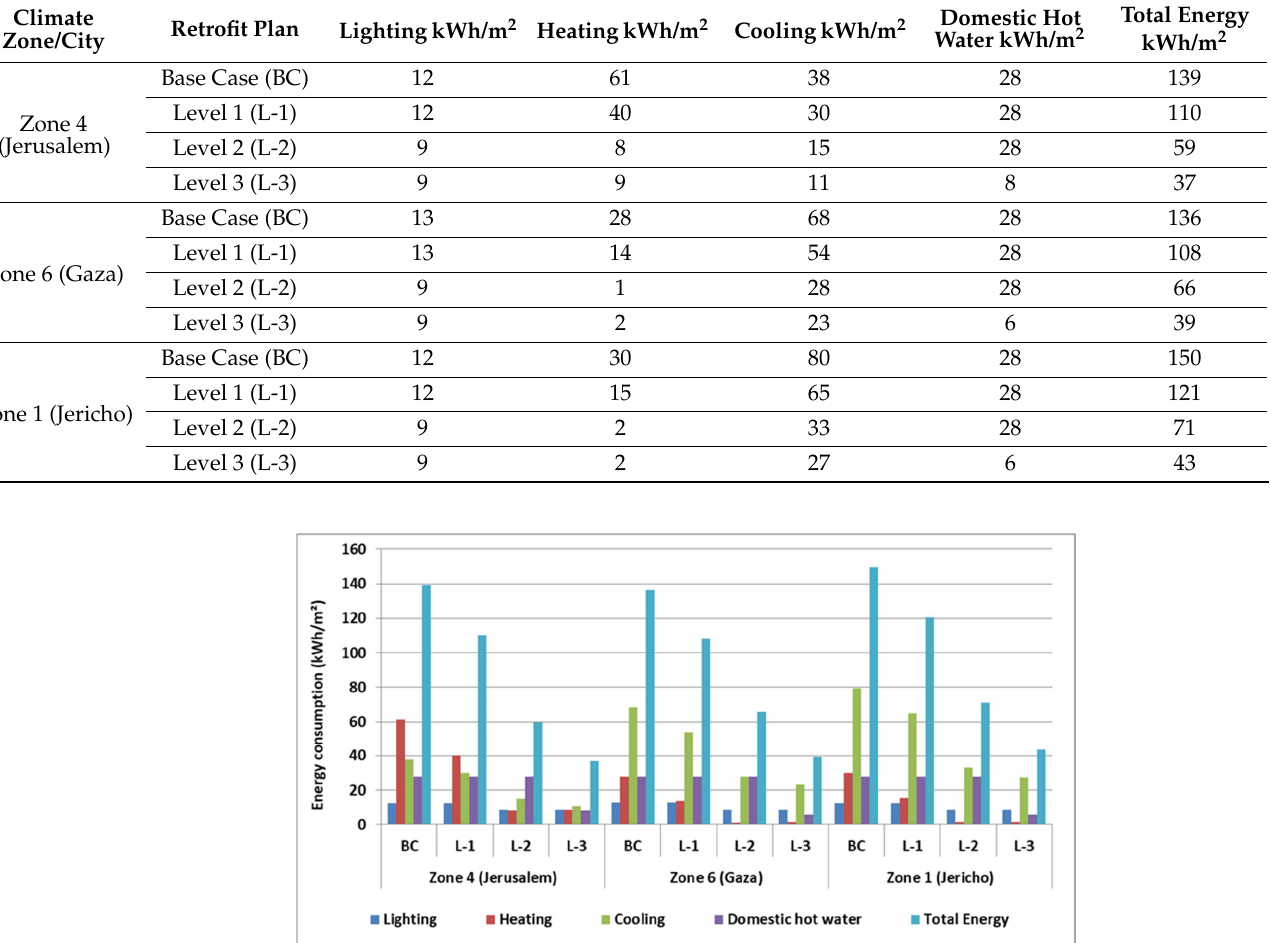
Table 1. Results from the simulation for energy consumption for lighting, heating, cooling, and domestic hot water, comparing the base case scenario with the three-level retrofit plans for buildings with two units per floor area.